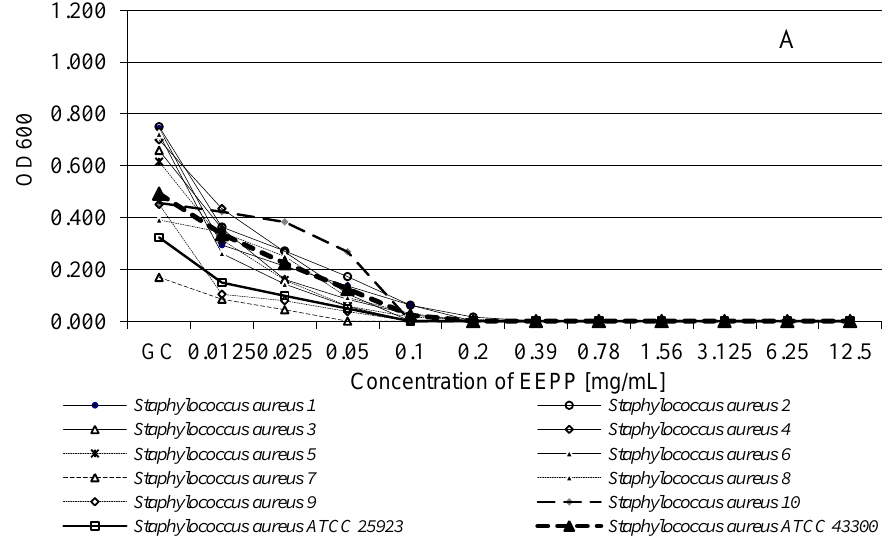
Figure 4. Growth of S. aureus strains in the presence of different EEPP concentrations. ( A ) After 6 h of incubation; ( B ) After 12 h of incubation; ( C ) After 24 h of incubation; GC: Growth